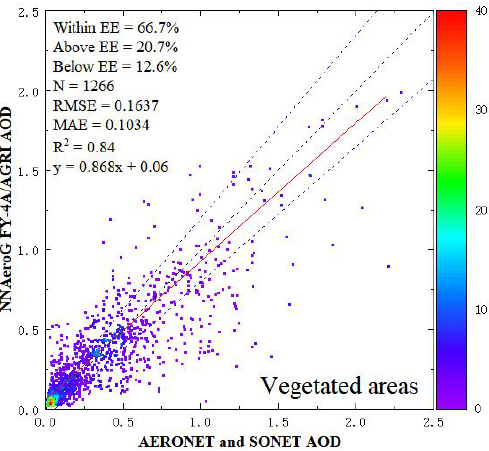
Figure 5. Scatterplots of FY-4A/AGRI retrieved AOD versus AERONET and SONET reference data over vegetated areas. The blue lines are the EE envelopes for AOD of ± (0.05 + 15%). The red line is the linear fitting line of AOD. The black line represents the 1:1 line.